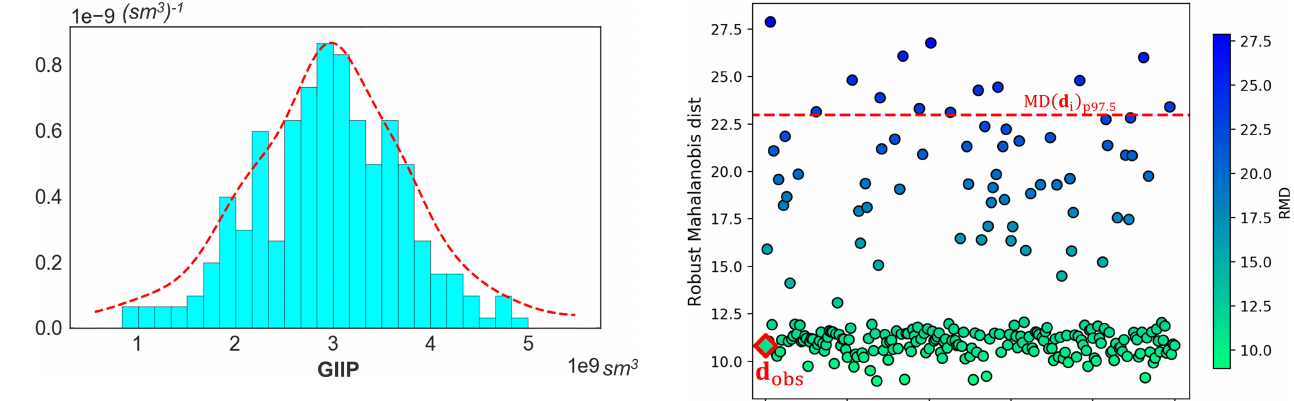
Table 1 is a subjective statement of prior uncertainty. When new data are acquired, this statement can be tested, using a statistical test (Sect. 2.1.3) that may lead to a falsified prior.